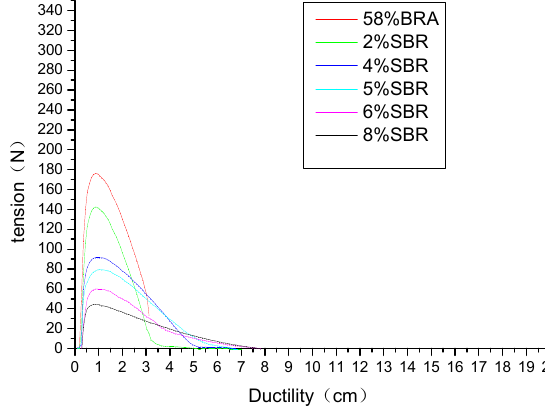
Figure 5. Ductility test of BRA–SBR composite modified asphalt.